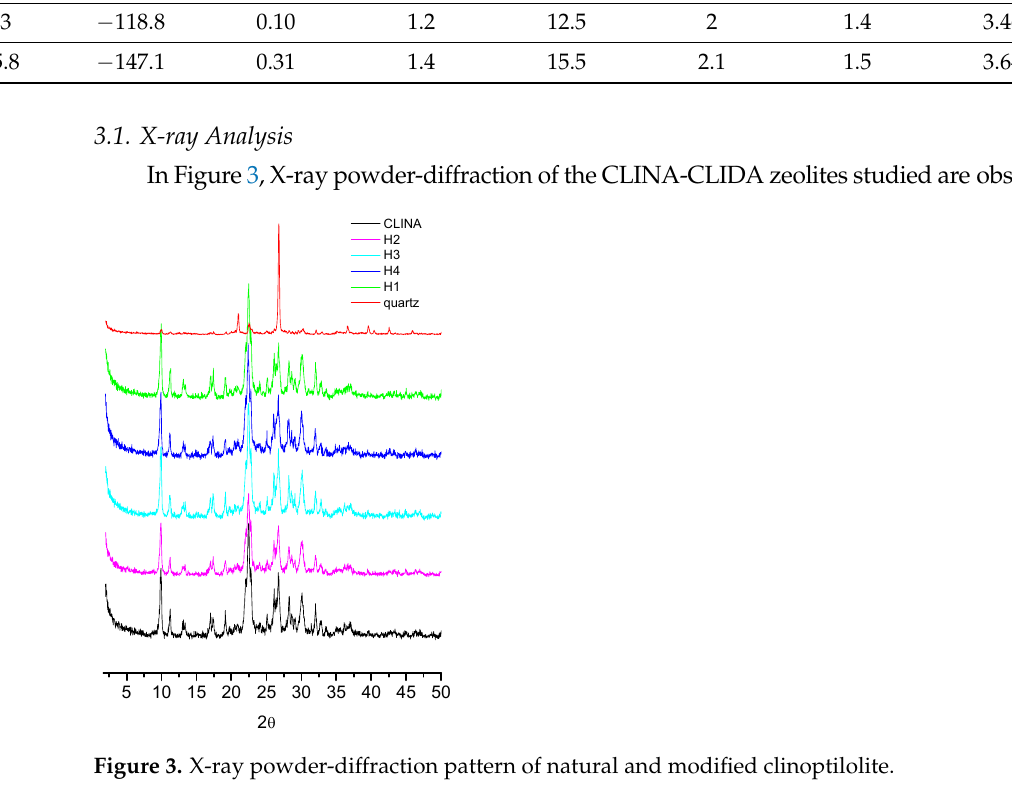
Table 1. Physical constant of adsorbate gases [23].